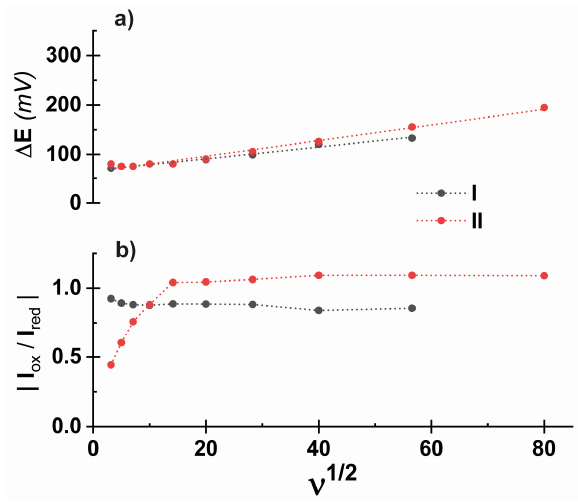
Figure 2. ( a ) Δ E vs. ν 1/2 ; ( b ) |I ox /I red | vs. ν 1/2